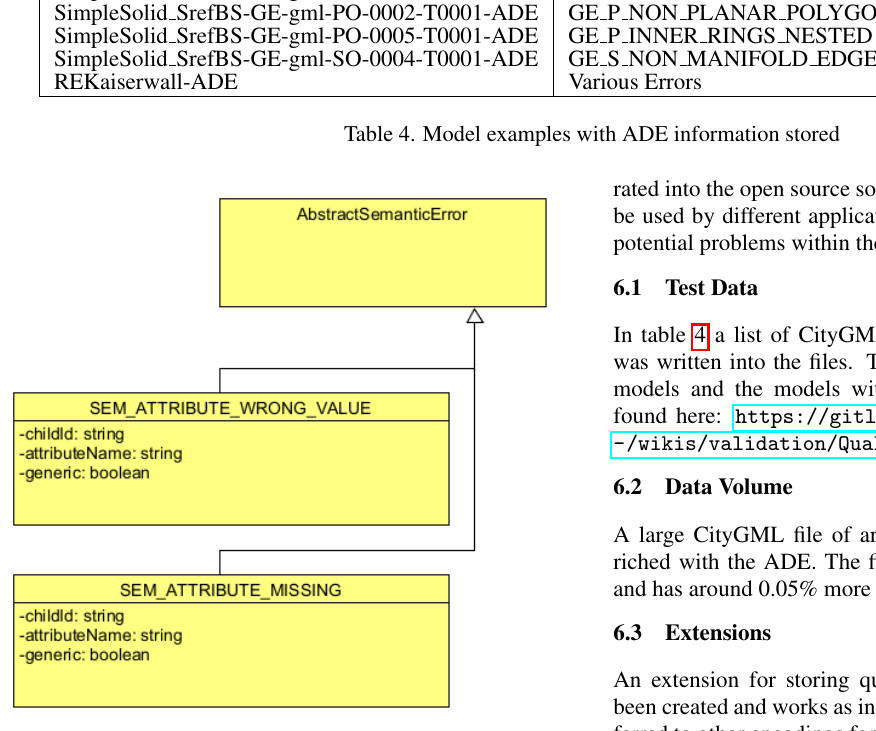
Figure 8. Semantic Error